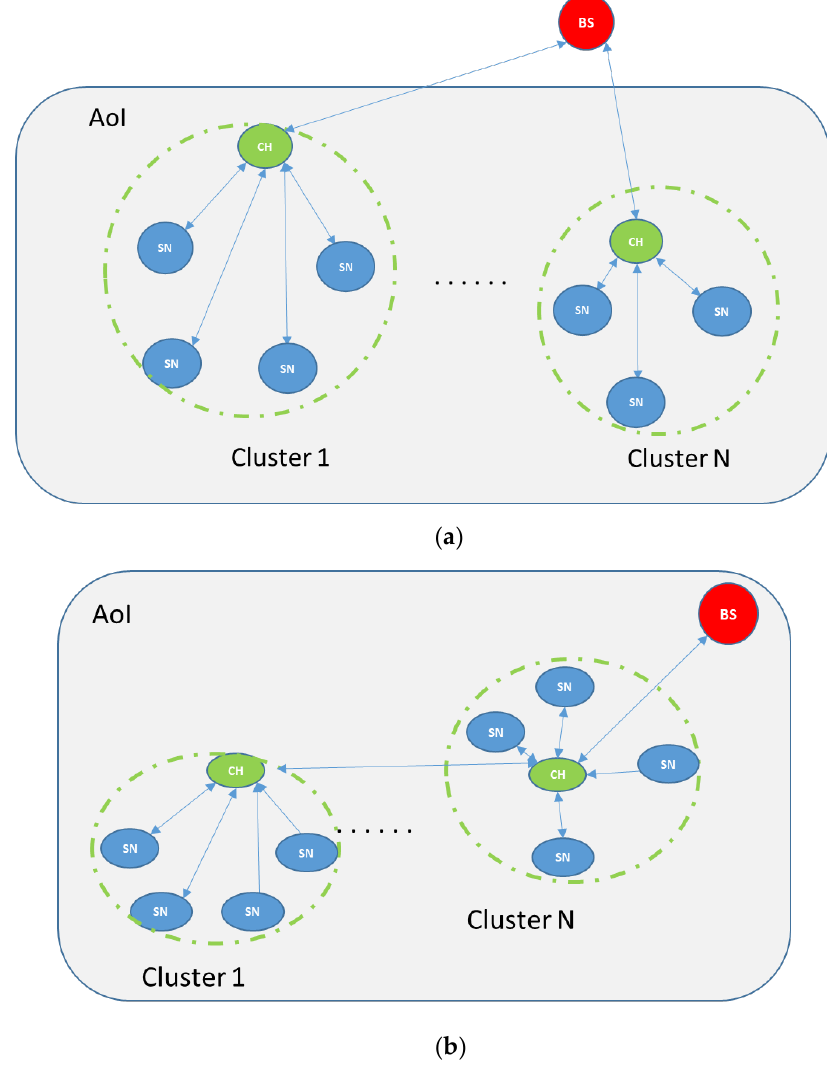
Figure 2. Multi-cluster WSN depicting cluster head (CH) to base station communication through a (a) direct or (b) an indirect communication via other CH(s) within the Area of Interest (AoI)